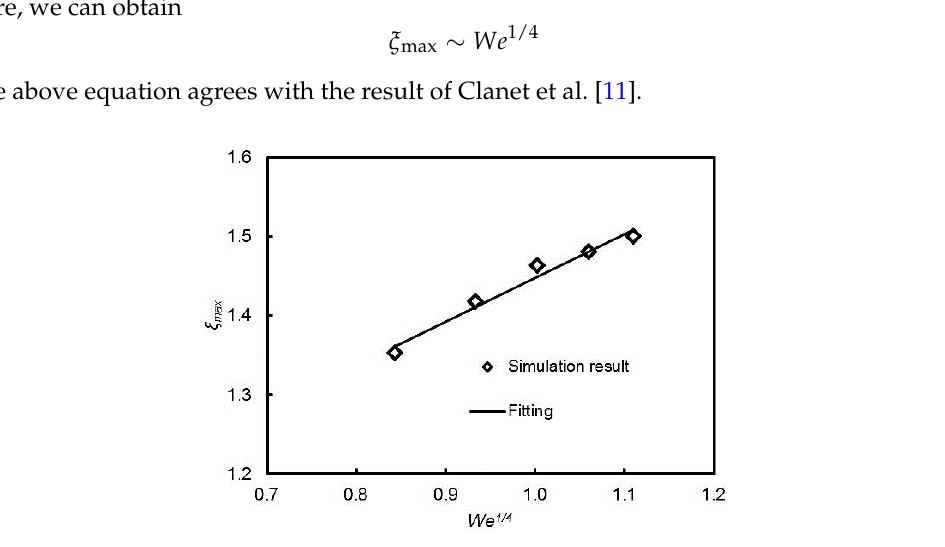
Figure 6. Maximum deformation ratio as a function of We 1/4 under different diameters.